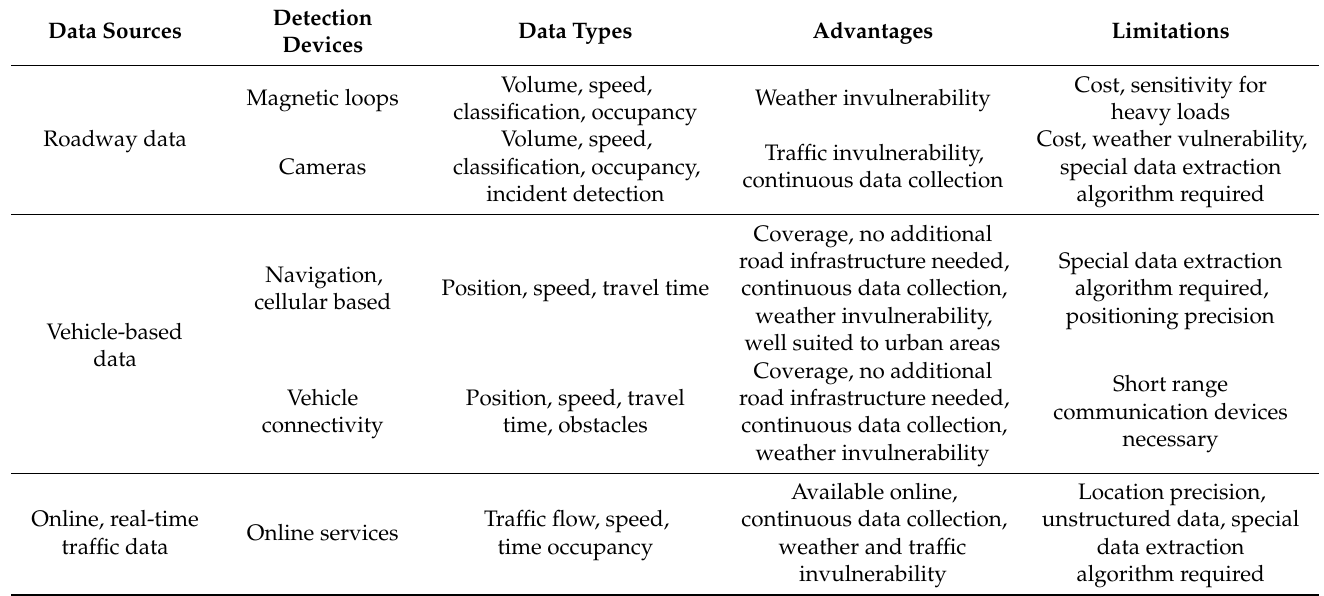
Table 1. Data sources and collection technologies for ITS